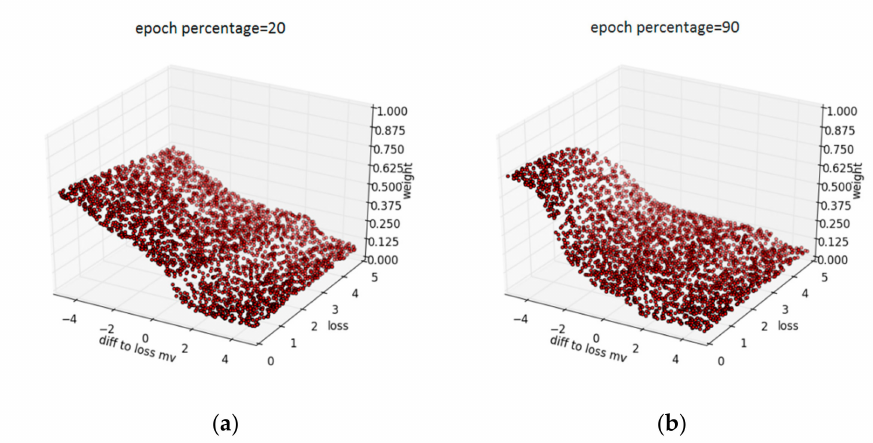
Figure 5. The data-driven curriculum learned by MentorNet: ( a ) Epoch percentage = 20 and ( b ) epoch percentage =